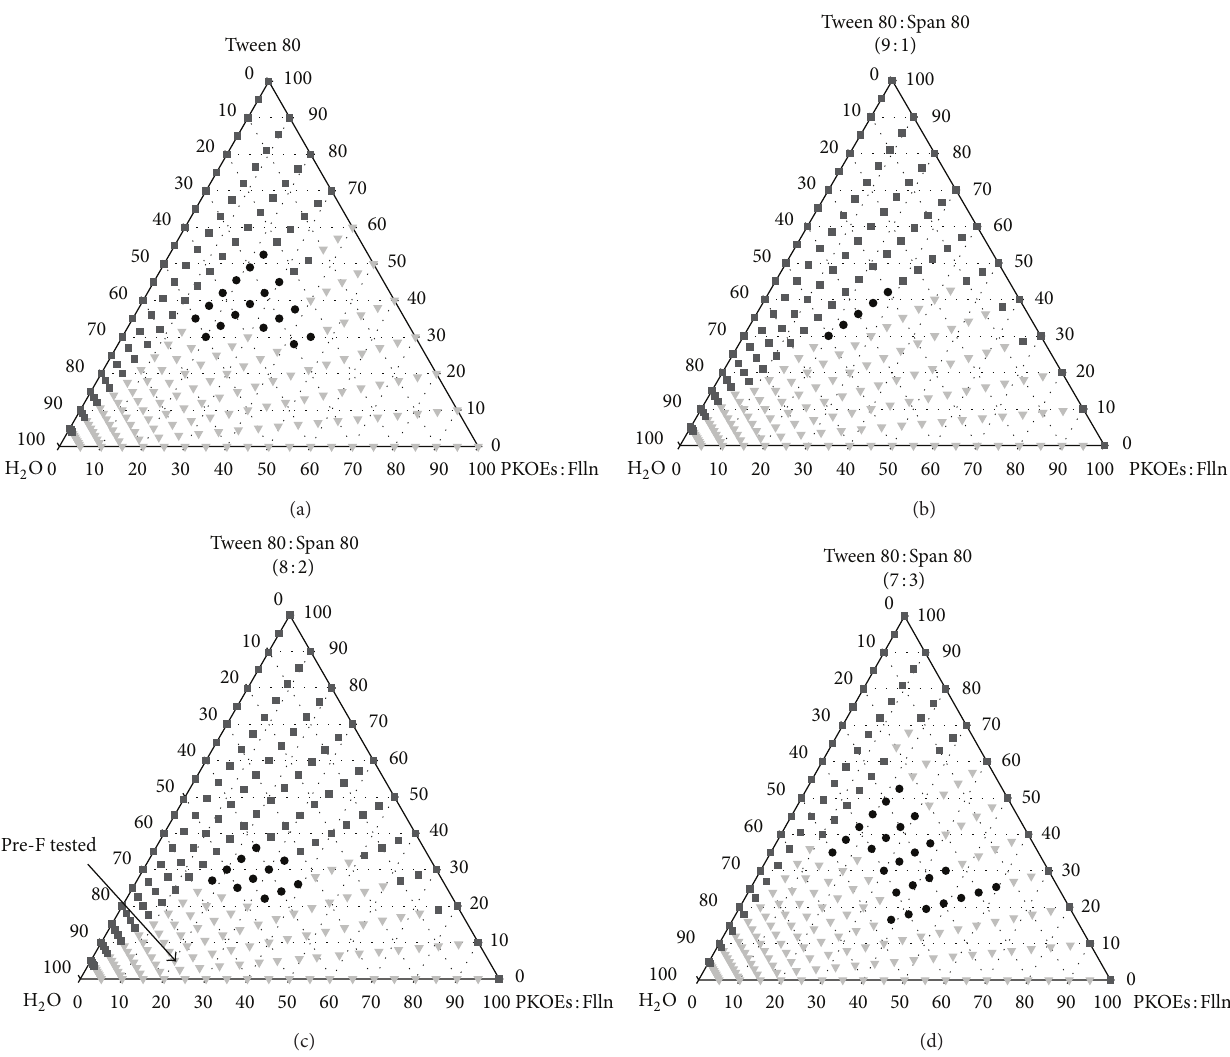
three cycles. Visual assessment under cross polarized plates was done to evaluate the physical appearance of the